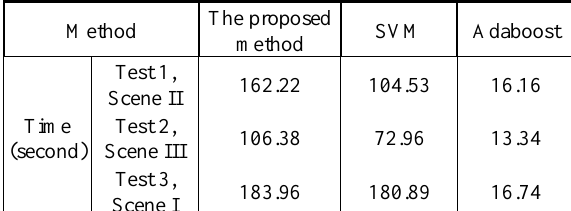
Figure 6 DIM points of a village in Zhengding City, Hebei Province The proposed Method method